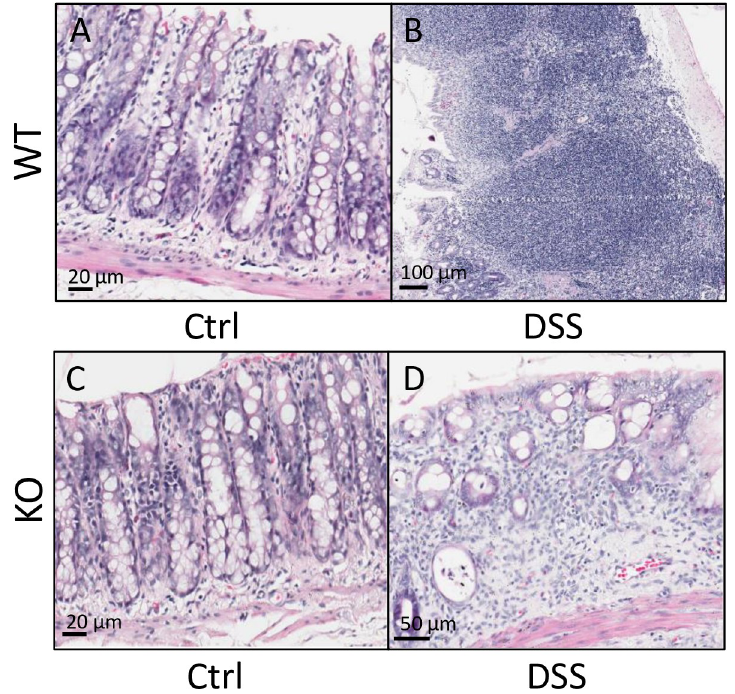
Fig 13. DSS exposure causes colonic damage in WT and Hamp KO rats. Rats were euthanized at the conclusion of the treatment course and at necropsy, dissected colonic sections were processed into Swiss Rolls to allow for microscopic analysis. Representative H&E-stained sections from wildtype males illustrate immune cell infiltration, and structural damage in the distal colon with DSS treatment ( A , B ). Similar pathological changes were observed in KO rats ( C , D